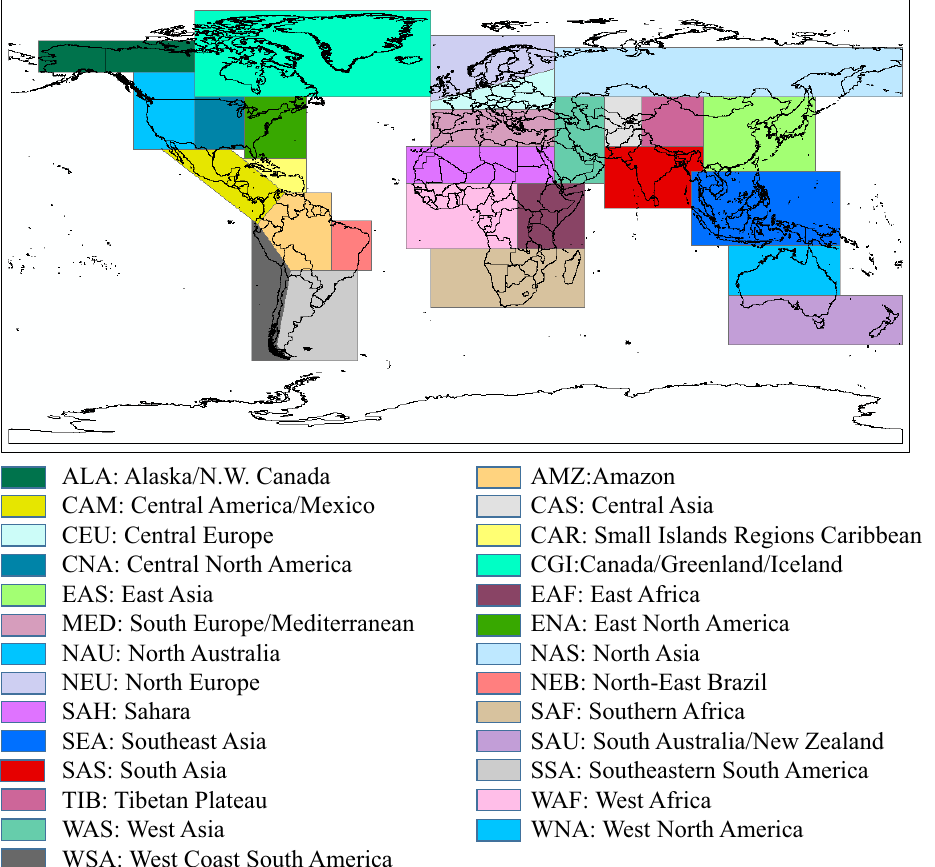
Fig. 1 Spatial boundaries of the geographical regions based on the IPCC 5th Assessment Report. This map shows the locations and boundaries of 27 climate reference